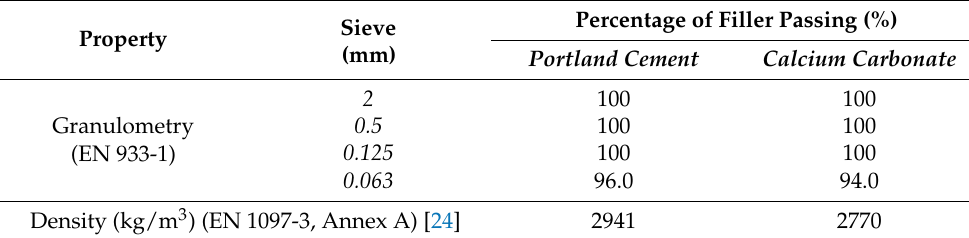
Table 3. Characteristics of the fillers employed.